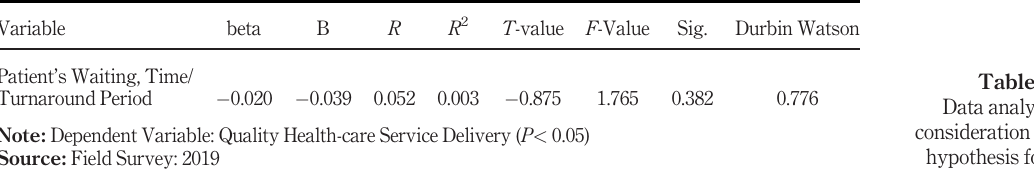
Table 6. Data analysis